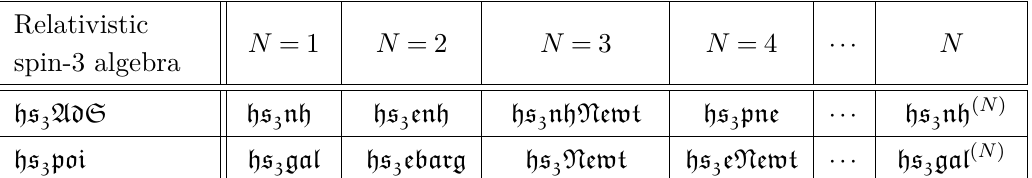
Table 1 . Non-relativistic expansions of spin-3 AdS and spin-3 Poincaré